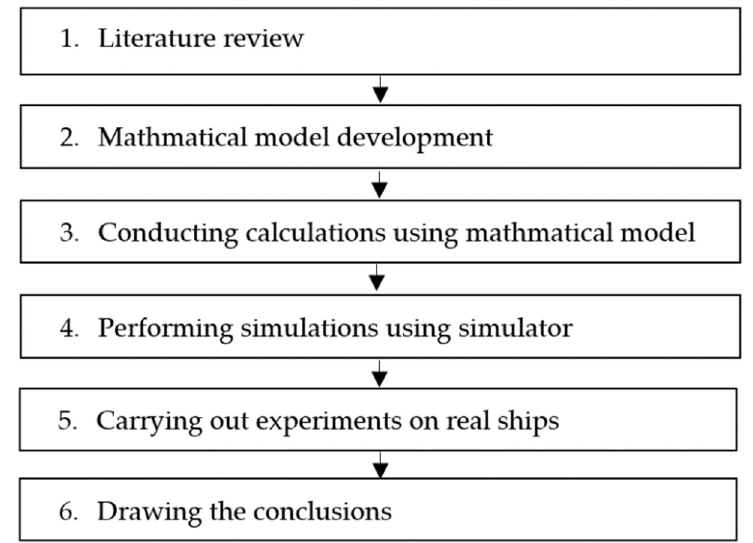
Figure 7. The steps of research methodology.